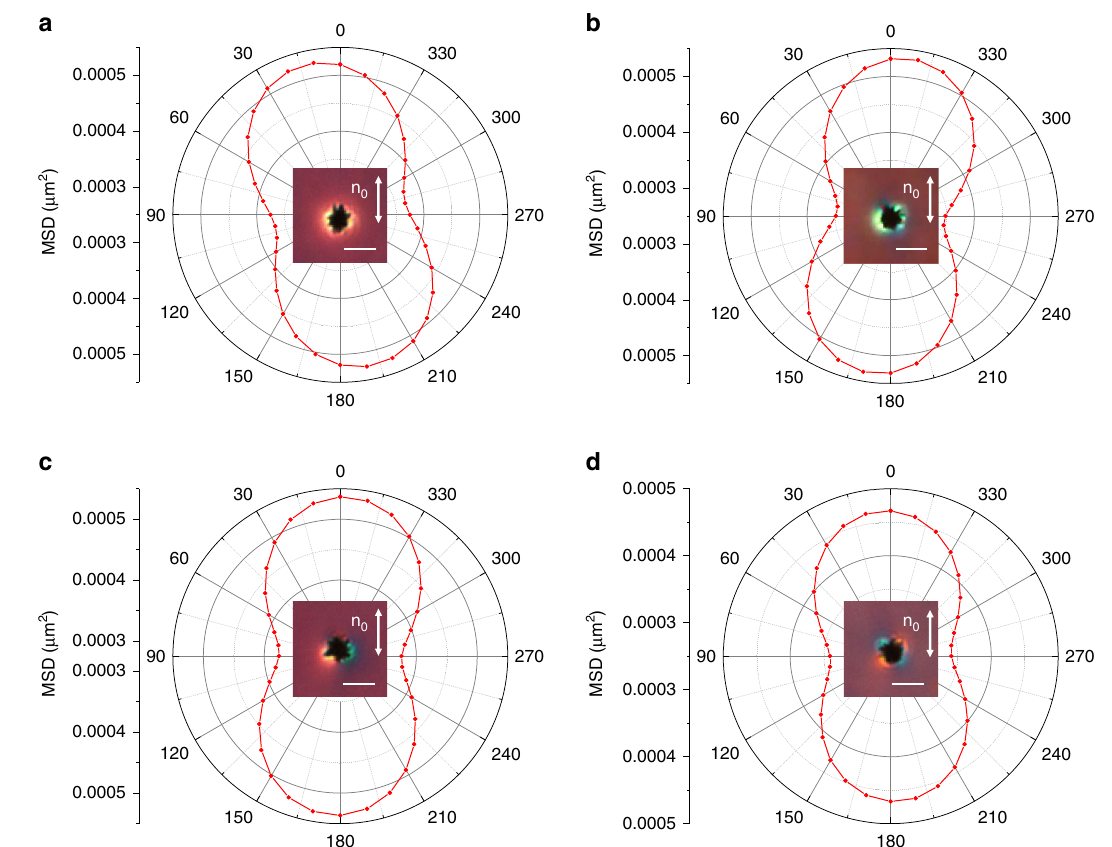
Fig. 2 Anisotropic Brownian motion of meso fl owers inducing different elastic multipoles. a , b Angular-dependent mean square displacement (MSD) of meso fl owers inducing elastic monopoles of opposite signs, as probed with respect to n 0 . c , d MSD angular dependence of meso fl owers inducing dipolar ( c ) and quadrupolar ( d ) elastic distortions. Insets show the corresponding polarizing optical micrographs of the studied particles, taken under crossed polarizers with a 530 nm retardation plate; white double arrows indicate n 0 . Scale bars are 3 μ